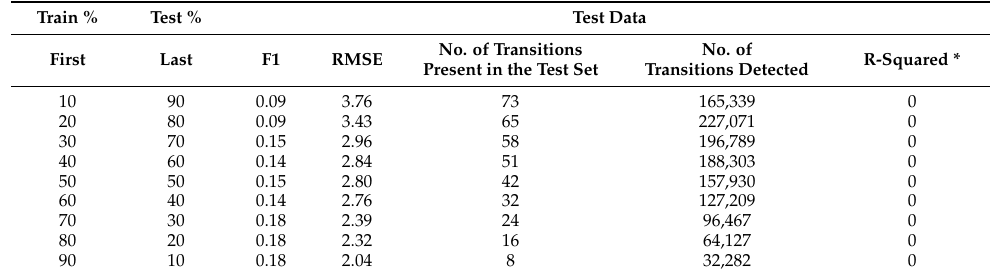
Table 5. Forecasting efficacy of the random forest model for different training and testing partitions. Train % Test